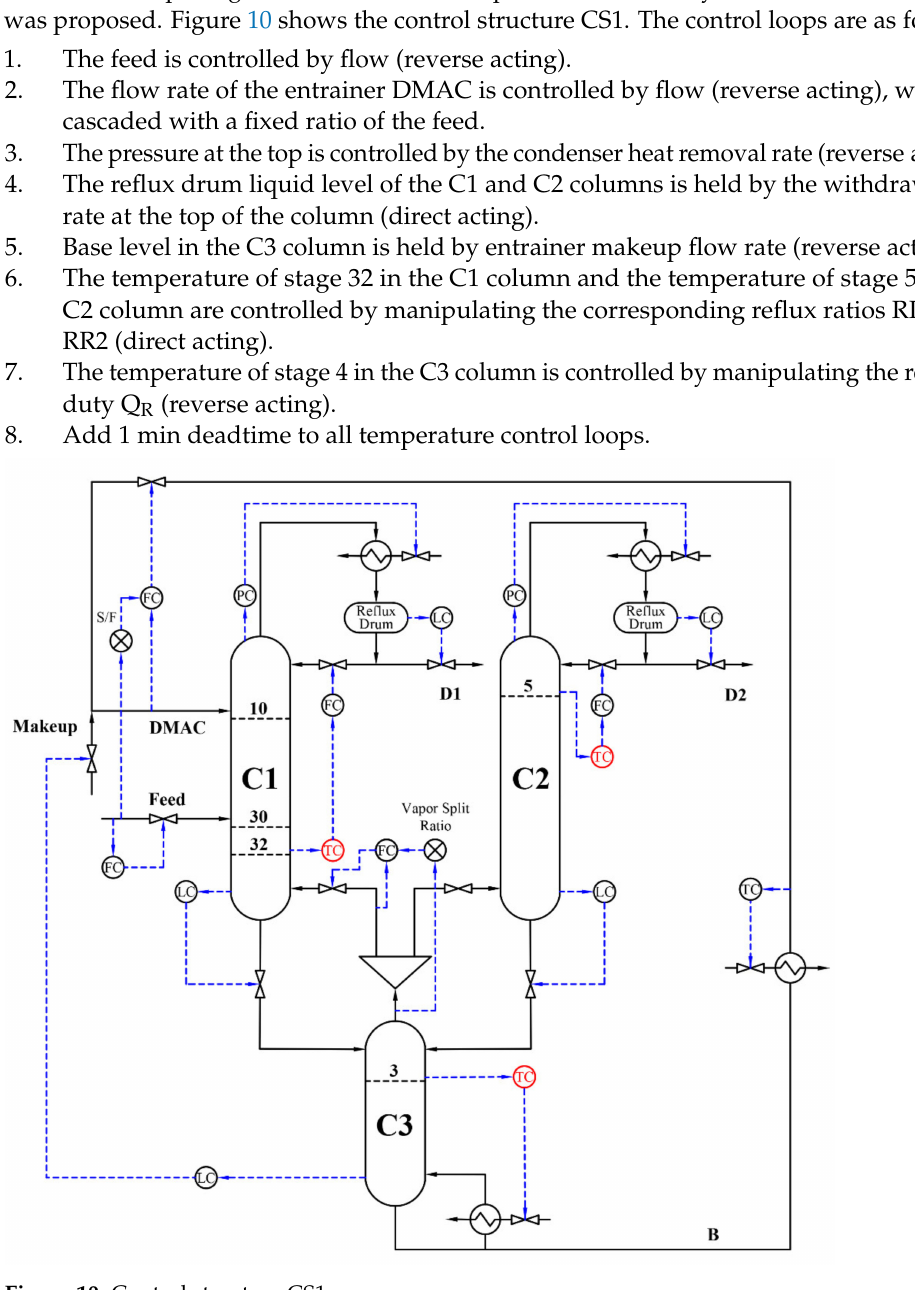
Figure 10. Control structure